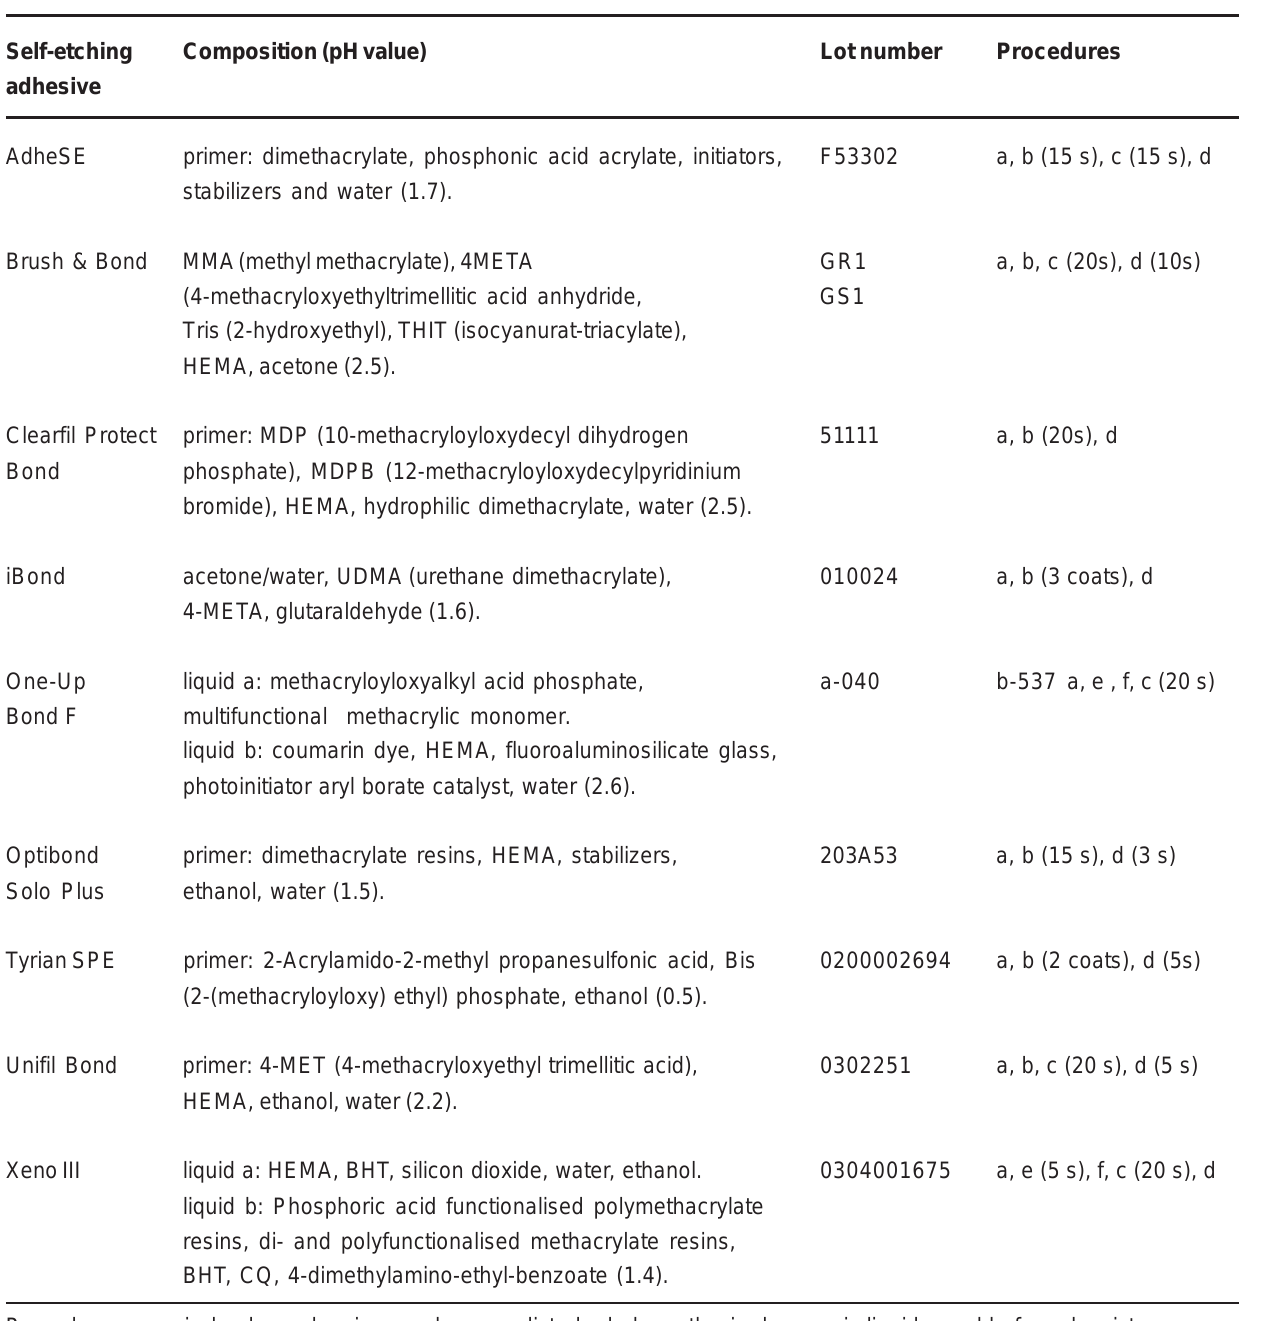
Procedures – a: air-dry; b: apply primer; c: leave undisturbed; d: gently air–dry; e: mix liquid a and b; f: apply mixture. Abbreviations – BHT: Butylated hydroxyl toluene; CQ: camphorquinone; HEMA: 2-hydroxyethyl